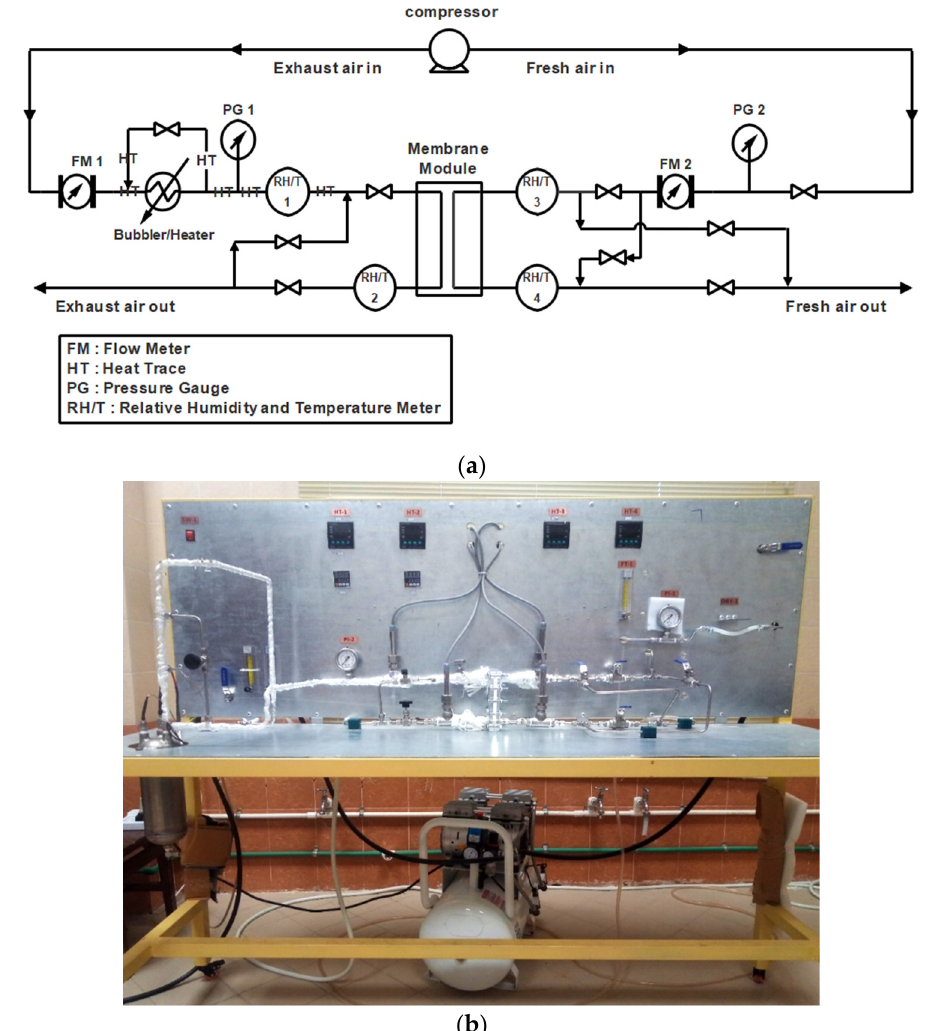
Figure 1. ( a ) Schematic flow diagram and ( b ) the experimental setup of the membrane-based heat exchanger for air dehumidification.